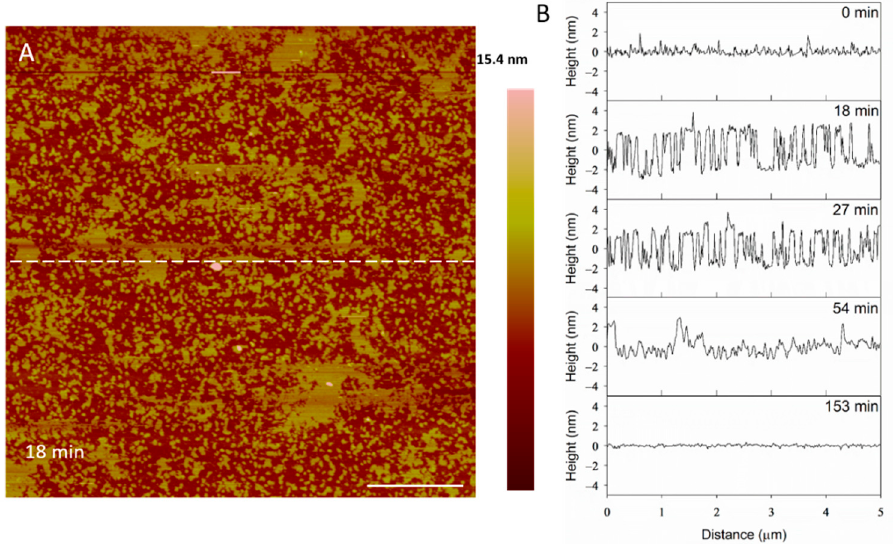
Figure 11 . Filling of PC membrane defects over time with 10 µM indolicidin. The dashed line ( A ) Figure 11. Filling of PC membrane defects over time with 10 µ M indolicidin. The dashed line ( A ) shows the location of the height profiles ( B ). The scale bar is 1 µm. shows the location of the height profiles ( B ). The scale bar is 1 µ m.